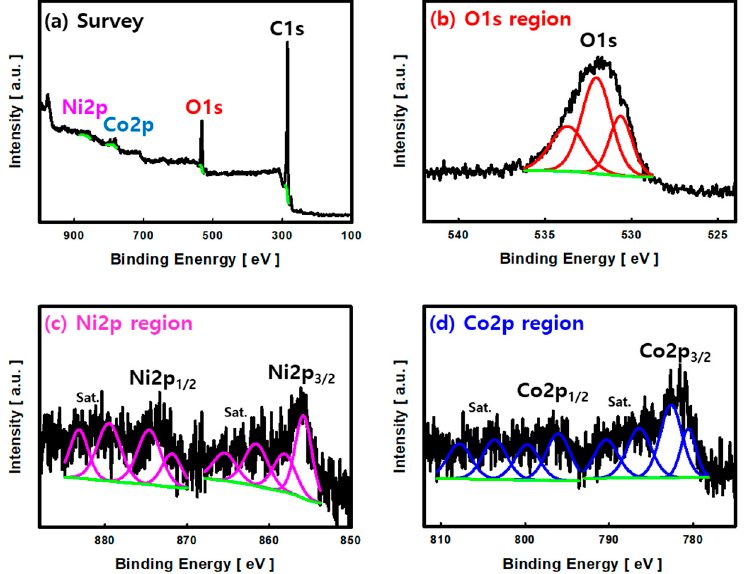
Figure 4. ( a ) wide-scan XPS spectrum, ( b ) O1s, ( c ) Ni2p and ( d ) Co2p XPS spectra of the NCOCC-55 prepared by PiLP.